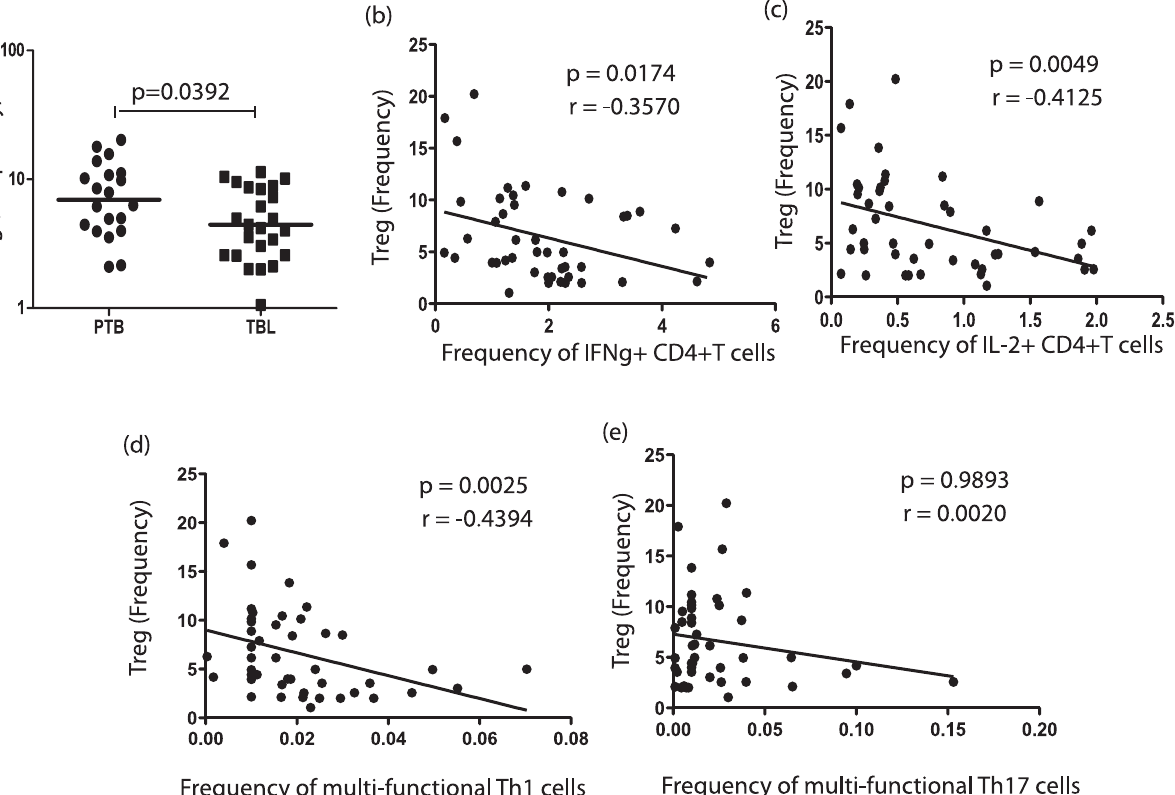
Figure 4. Tuberculous lymphadenitis (TBL) is associated with decreased frequencies of natural regulatory T cells (nTregs), which exhibit a negative relationship with mono- and multifunctional Th1 cells in TB-infected individuals. ( A ) Percentages of nTregs (defined as CD4 + CD25 + Foxp3 + CD127 dim by flow cytometry) in tuberculous lymphadenitis (TBL) and pulmonary TB (PTB) individuals. ( B–E ) Ex vivo frequencies of nTregs were correlated with the baseline frequency of CD4 + T cells expressing IFN- c alone ( B ), IL-2 alone ( C ). IFN- c , IL-2, and TNF- a ( D ), or IL-17A, IL- 17F, and IFN- c ( E ) in all TB-infected individuals ( n =45). P values were calculated using the Spearman rank correlation test.